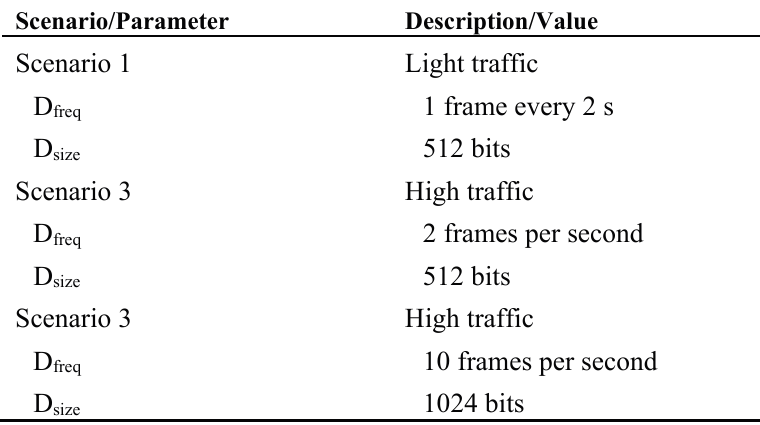
Table 8. Parameter settings for context-aware and non-context aware DR-MAC/DAAM protocol sets.